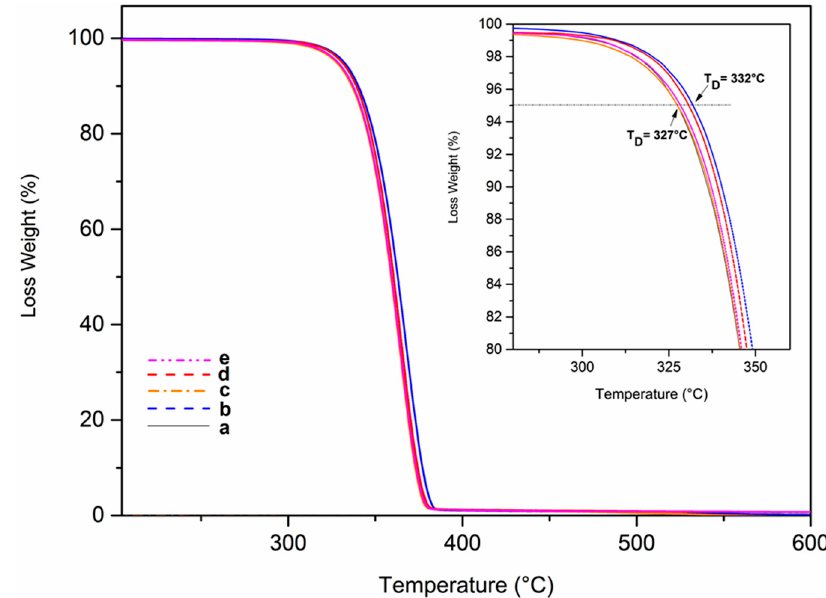
Figure 6. TGA scans for the virgin PLA pellet ( a ) and for extruded samples after microcompounding: ( b ) neat and with ( c ) 0.1 wt % of LSAG; ( d ) 0.1 wt % of HSAG; ( e ) 0.1 wt % of CB. Experimental conditions: a heating rate of 10 K/min under an N 2 atmosphere.